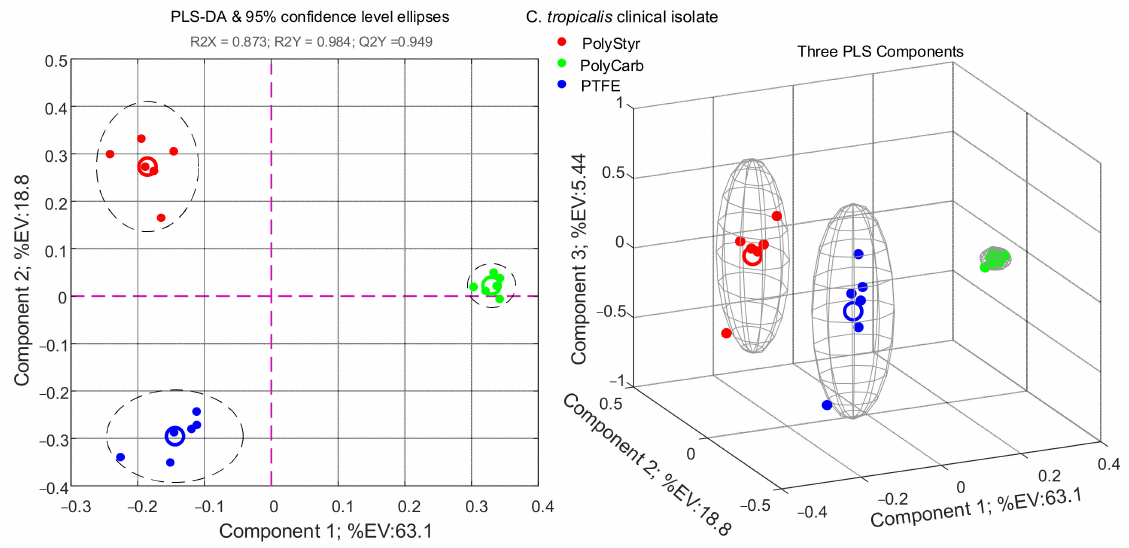
Figure 4. PLS-DA analysis of intracellular metabolites extracted from cells of the clinical isolate of Candida tropicalis harvested from biofilms grown (72 h) on polystyrene (PolyStyr class), polycarbonate (PolyCarb class), and Teflon (PTFE